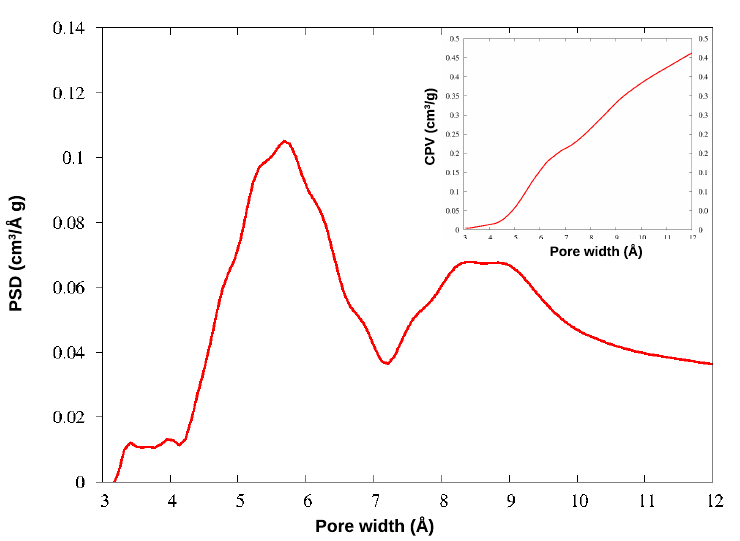
Figure 6. PSD and CPV for KPS-1 from CO 2 adsorption at 273 K.